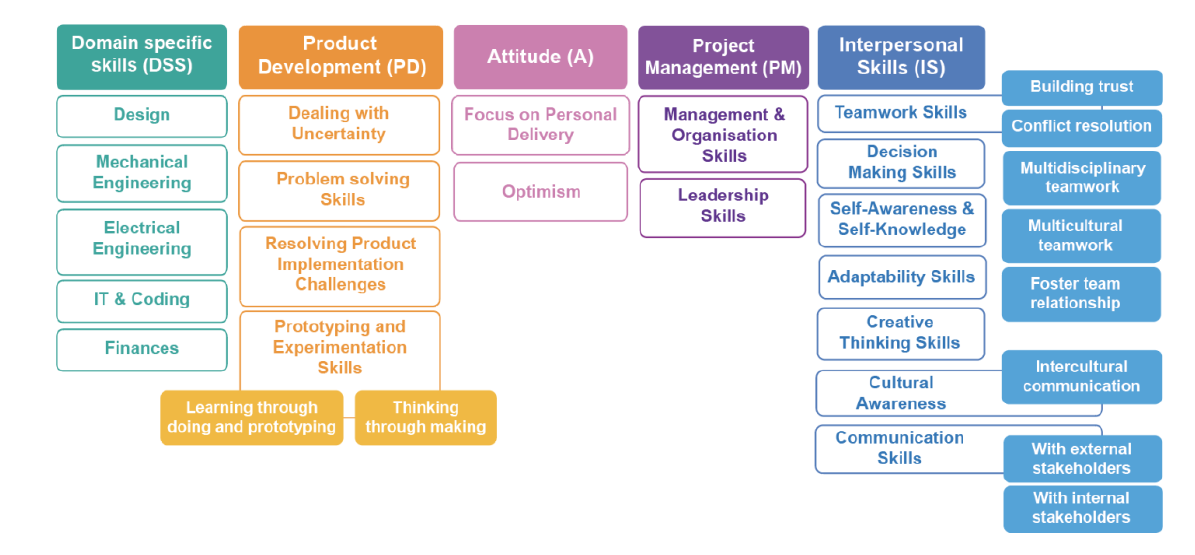
Fig. 2. Core learning